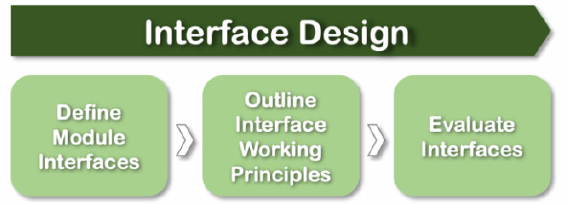
Figure 4. Interface Design Methodology (IDM)